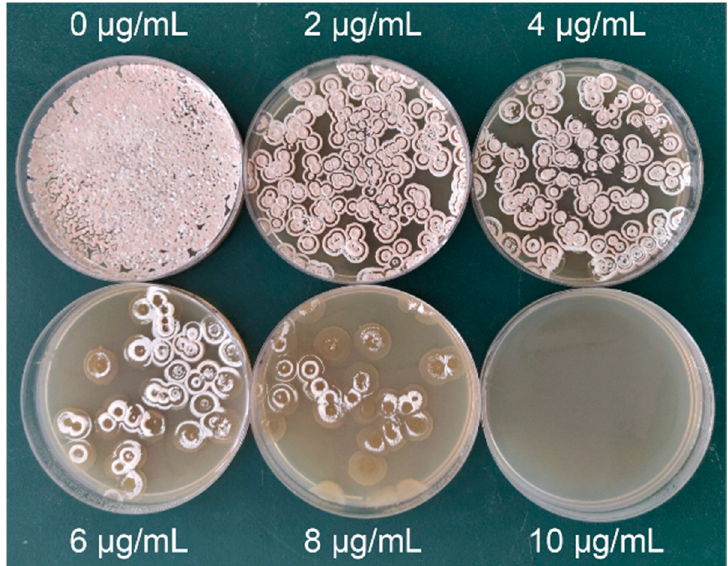
Figure 3. Prescreening mutant strains on resistant plates containing different streptomycin concen- trations (0, 2, 4, 6, 8, and 10 μ g/mL). Table 1. The distribution fraction of mutant strains on streptomycin resistance plates. Distribution Fraction of Mutant Strains with Different NM Potency The Concentrations of Streptomycin ( µ g/mL)